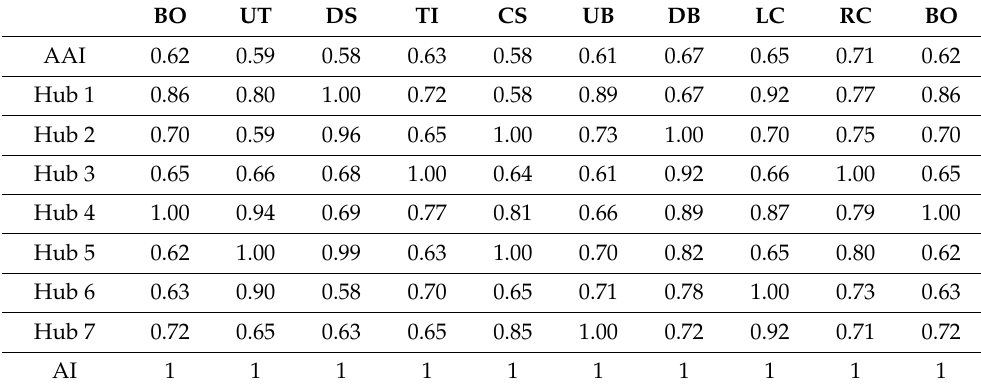
Table 10. The normalized matrix.